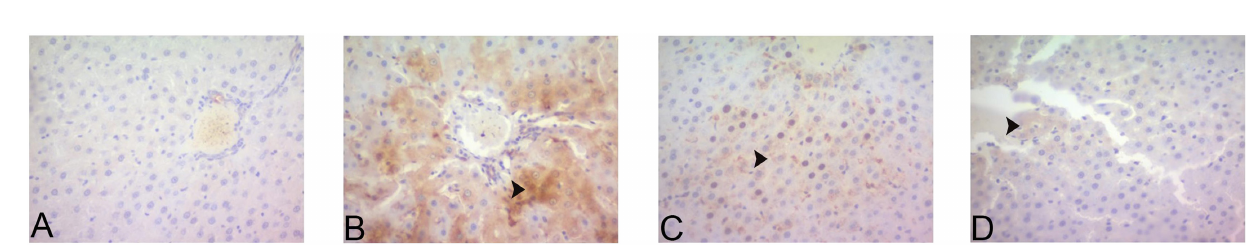
Figure 4. Representative micrographs showing iNOS expression for all experimental groups. Control group I (A) showing İ NOS immune negativity. Ischemia-reperfusion group II (B) shows severe iNOS expression (arrowhead) compared to the control group. Group III (C) shows moderately iNOS expression (arrowhead) compared to group II. Group IV (D) shows mild iNOS expression (arrowhead) compared to group II. × 20 immunohistochemical staining.